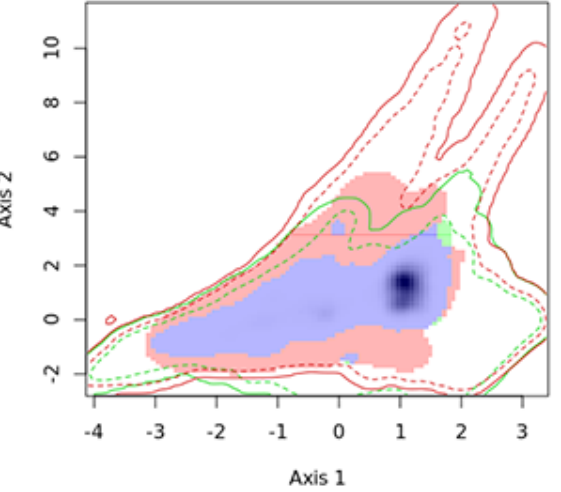
Fig 3 . Climatic environment based on a principal component analysis of the environment (PCA-env) of Apis mellifera Linnaeus, 1758. The blue polygon corresponds to niche overlap, the red polygon corresponds to niche expansion, and the green polygon corresponds to niche unfilling. Solid lines represents the total native (red) and total exotic (green) ranges and dashed lines represents 75% of the ocurrences of native (red) and exotic ranges